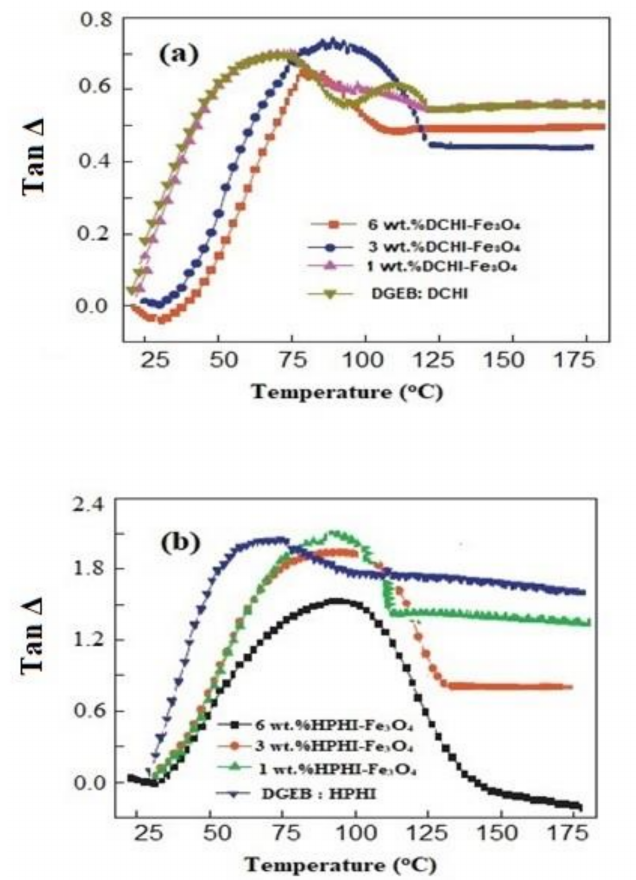
Figure 10. Dynamic mechanical thermal analyzer (DMA) tan ∆ vs. curing temperatures of ( a ) DGEB / DCHI and ( b ) DGEB / HPHI and their magnetite NPs.